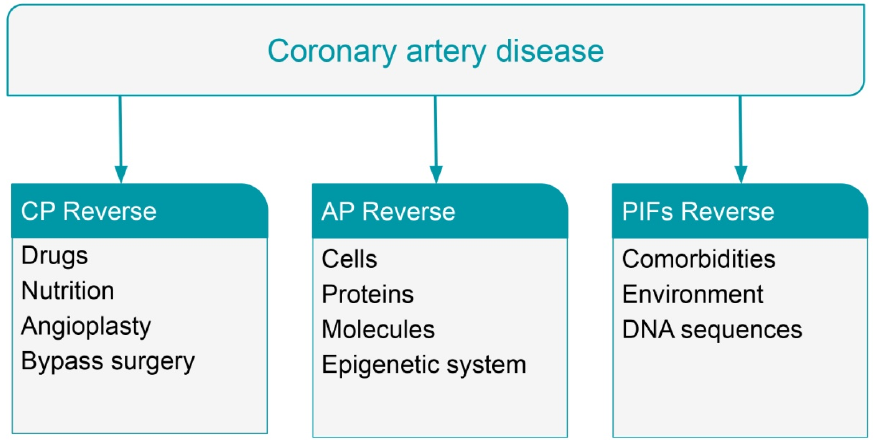
Figure 4. Potential reverse (partial or complete) of coronary artery disease (CAD) at the level of clinical phenotype (CP) or atherosclerotic plaque (AP) or Phenotype Influencing Factors